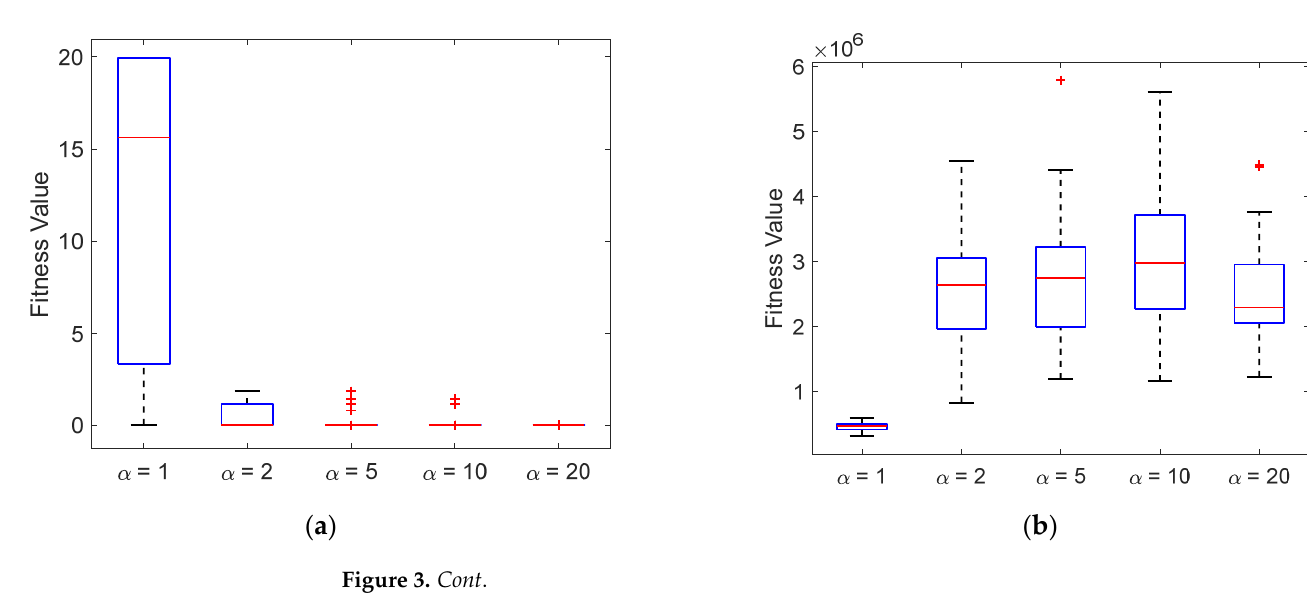
Table 2. Best fitness values of the cost functions for 50 simulations.